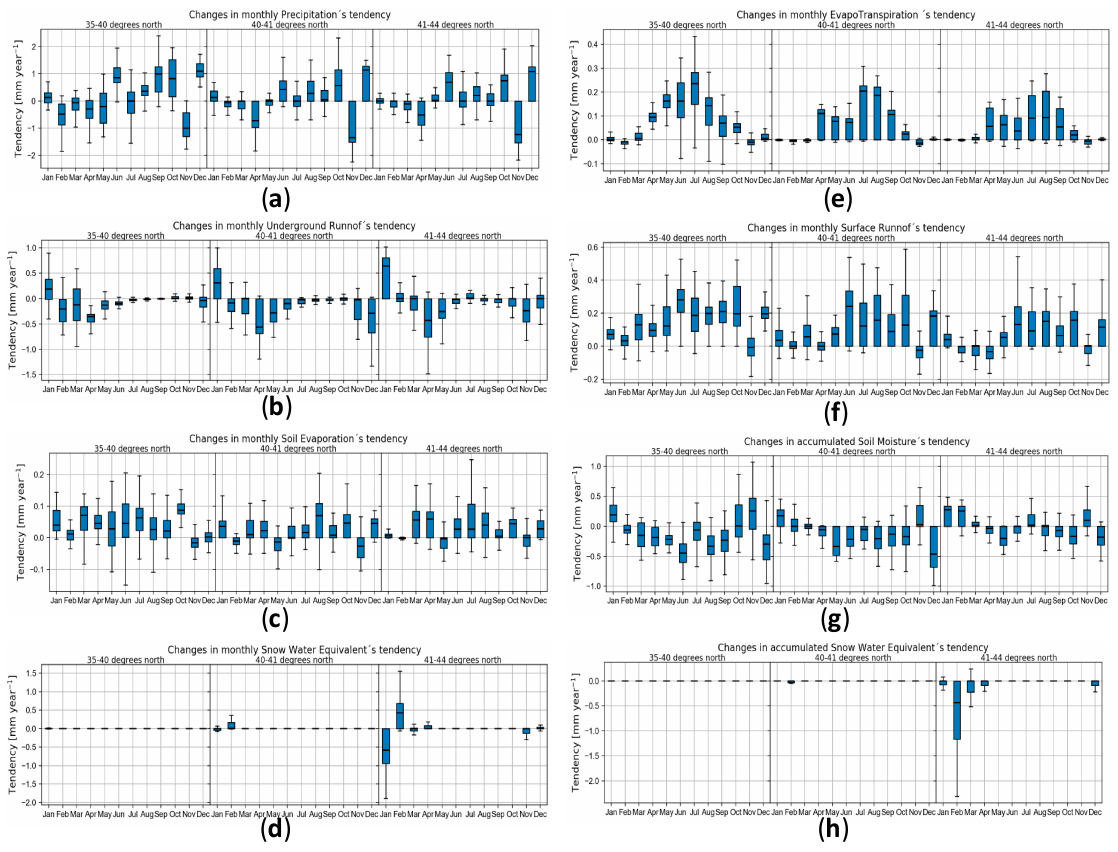
Figure 10. Monthly tendency in the water budget components: precipitation ( a ), underground runoff ( b ), soil evaporation ( c ), snow water equivalent (SWE) accumulation ( d ), evapotranspiration (ET) ( e ), surface runoff ( f ), soil moisture content ( g ), and SWE ( h ).